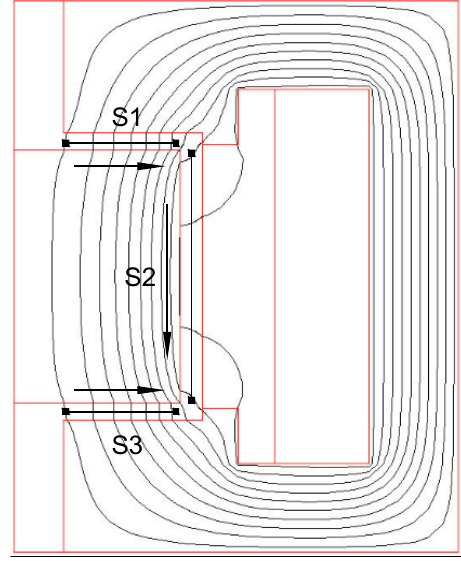
Figure 9. Distribution of magnetic flux lines.